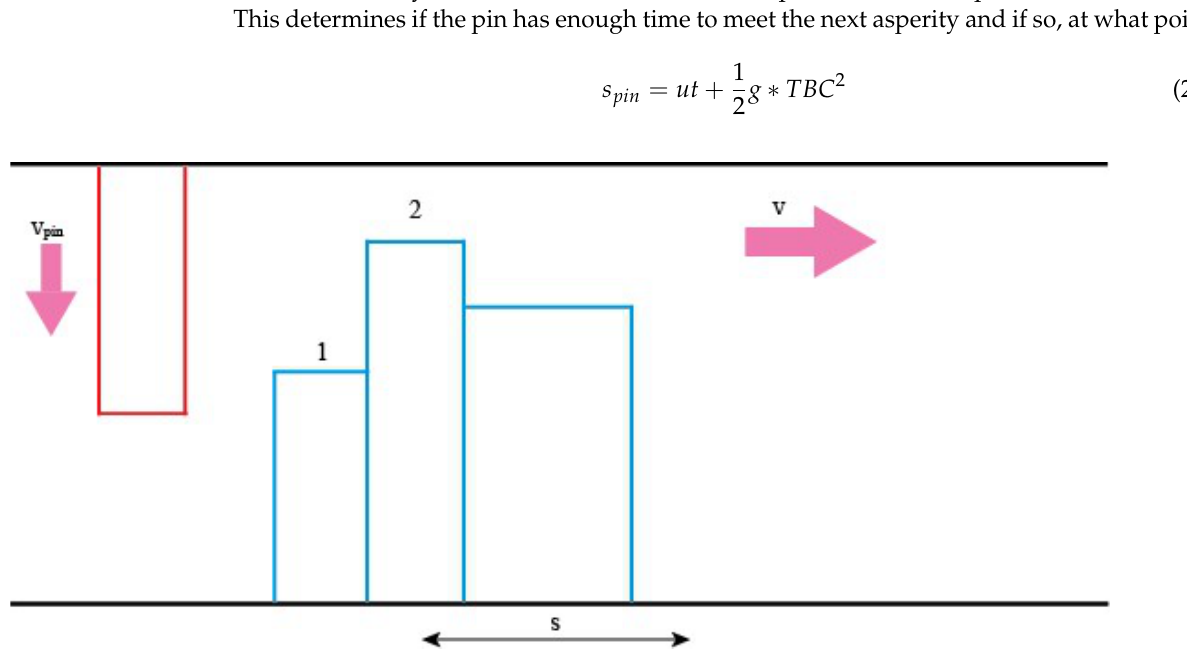
Figure 3. V is the relative velocity of the pin. s is the width of an asperity. TBC is the time taken for the pin to go from position 1 to position 2.